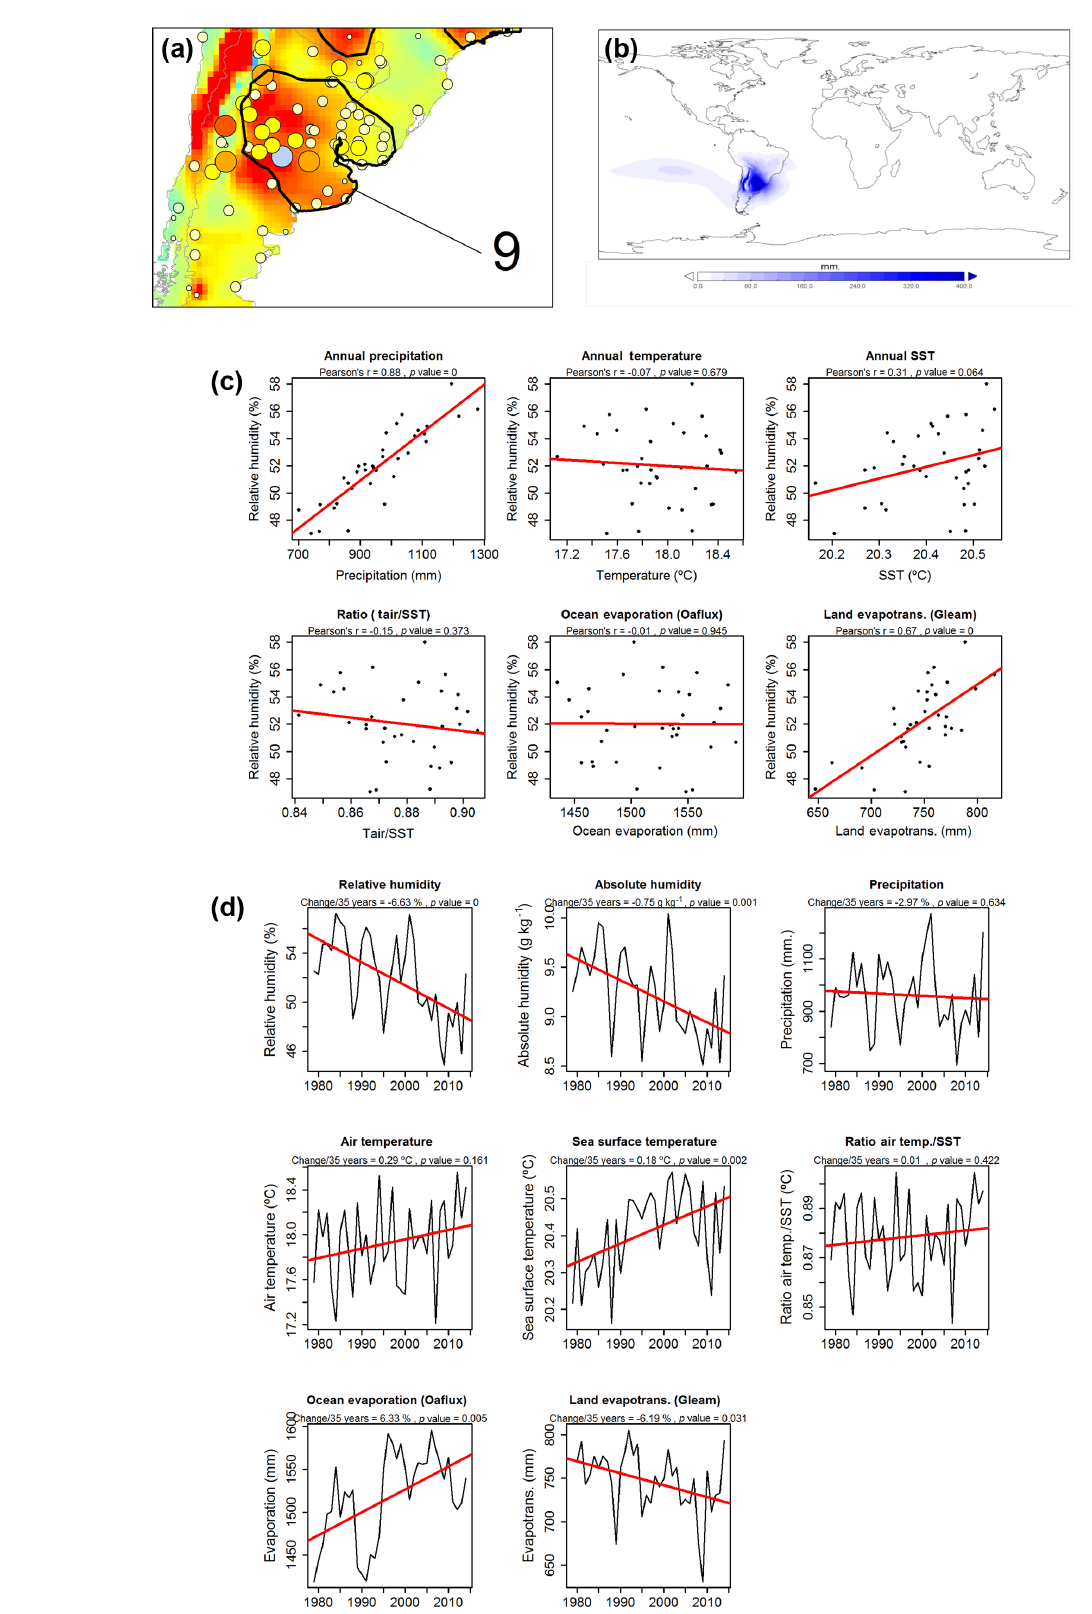
Figure 6. The same as Fig. 5 but for the La Plata (region 9). Earth Syst. Dynam., 9, 915–937, 2018